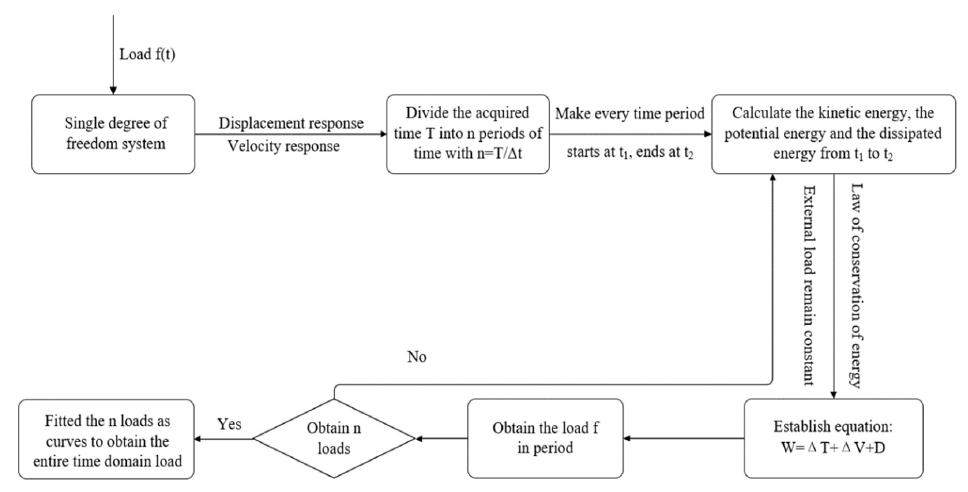
Figure 2. S ingle-degree-of-freedom system load identification.